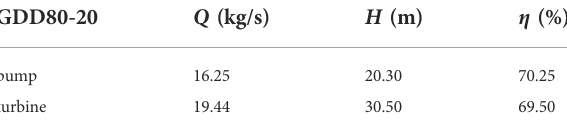
TABLE 9 GDD80-20 BEP point performance characteristic data.